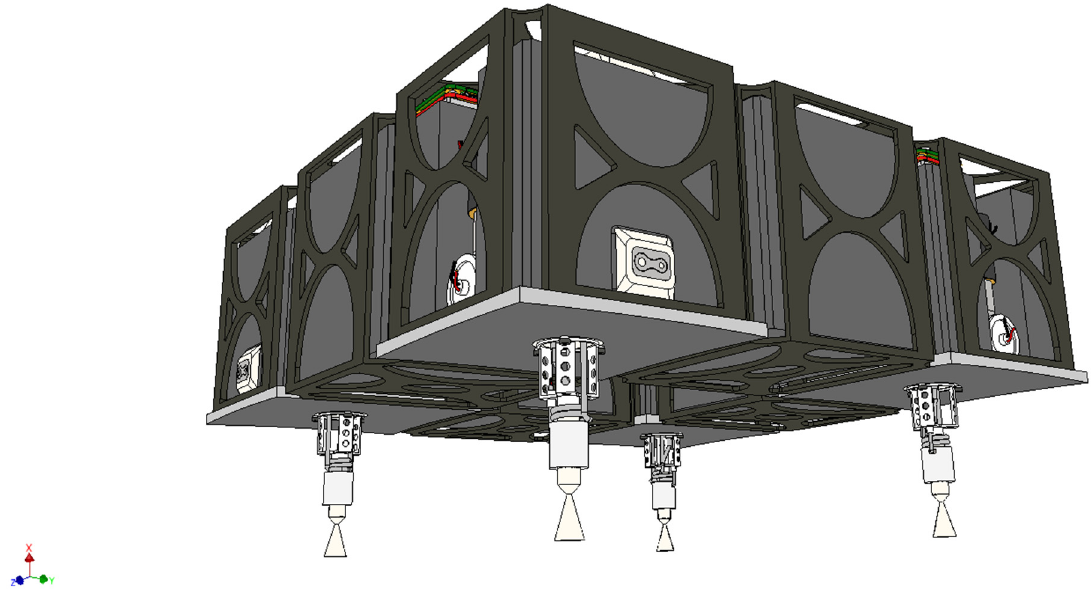
Figure A6. MIMPS-G500mN Cluster on a 27U CubeSat, 2 N Thrust, and four extension tanks.